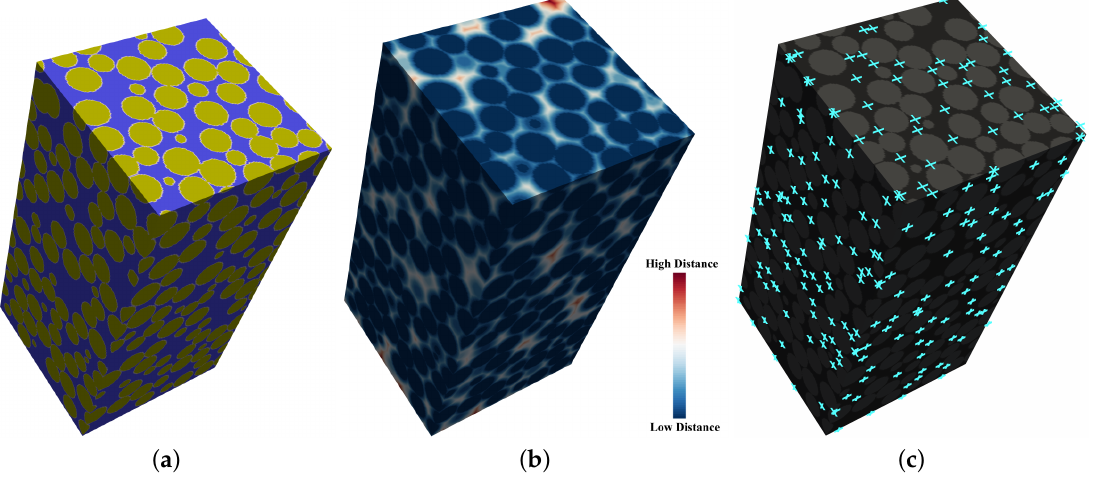
Figure 5. Very loose mono-sized packed spheres. ( a ) binary representation, in which solid and void are represented in yellow and purple, respectively; ( b ) EDT representation; ( c ) local void centers, represented by the light blue